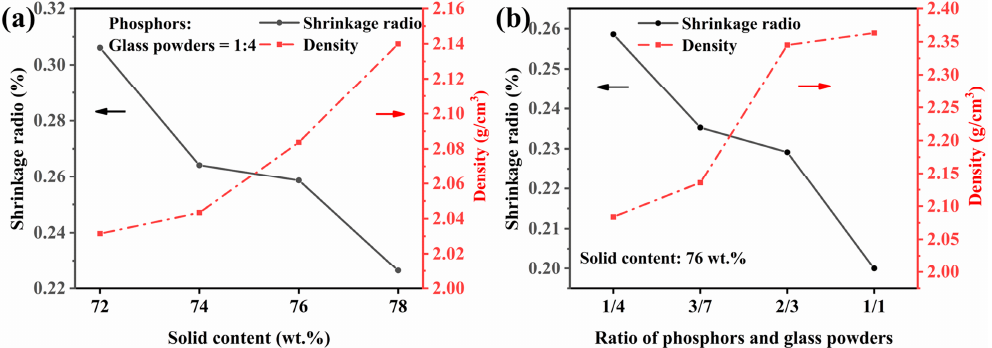
Figure 4. ( a ) The shrinkage ratios and densities of green bodies with different solid contents and ( b ) ratios of phosphors and glass powders. ( b ) ratios of phosphors and glass